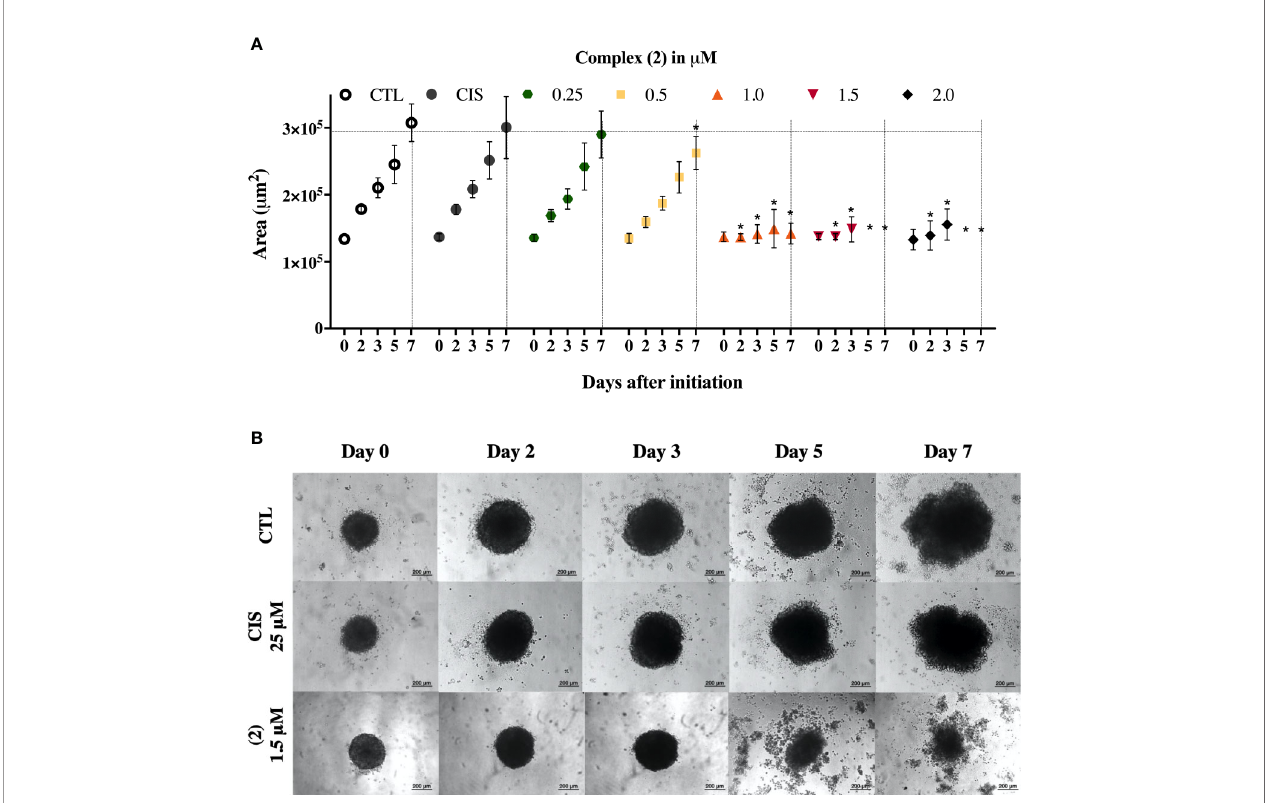
FIGURE 2 | Effect of the complex ( 2 ) in 3D in vitro model of multicellular tumor spheroids of DU-145 cells. (A) Routine monitoring of spheroid growth of DU-145 MCTSs treated with 0.25, 0.5, 1.0, 1.5, and 2.0 m M of complex ( 2 ) without medium renewal followed by 50% medium exchange every 48 h for further culturing. Every feeding step results in a consecutive 1:2 dilution of the treatment. Graph represents spheroid volume growth kinetics of DU-145 MCTSs in liquid overlay culture. (B) DU-145 MCTSs were examined using inverted microscope (ampli fi cation, 200×), scale bar = 200 m m. The negative control (CTL) was treated with the vehicle (0.1% DMSO) used for diluting the complex. Cisplatin (CIS 25 m M) were used as the positive controls. Data are presented as the mean ± S.E.M. of three independent experiments performed in triplicate. * p < 0.05 compared with the control by ANOVA followed by Dunnet ’ s